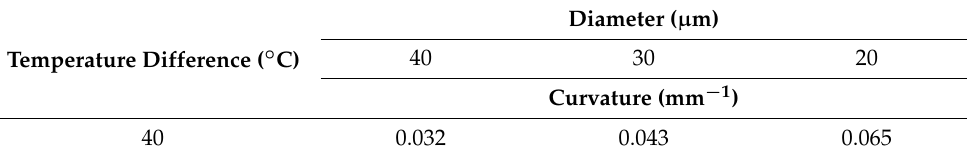
Figure 7. CTE vs. Draw ratios of bicomponent (2nd to 8th columns) and monocomponent fibers (Hytrel and Crastin, 1st and last columns) in the temperature ranges of − 20 °C to 0 °C and 0 °C to 20 °C.